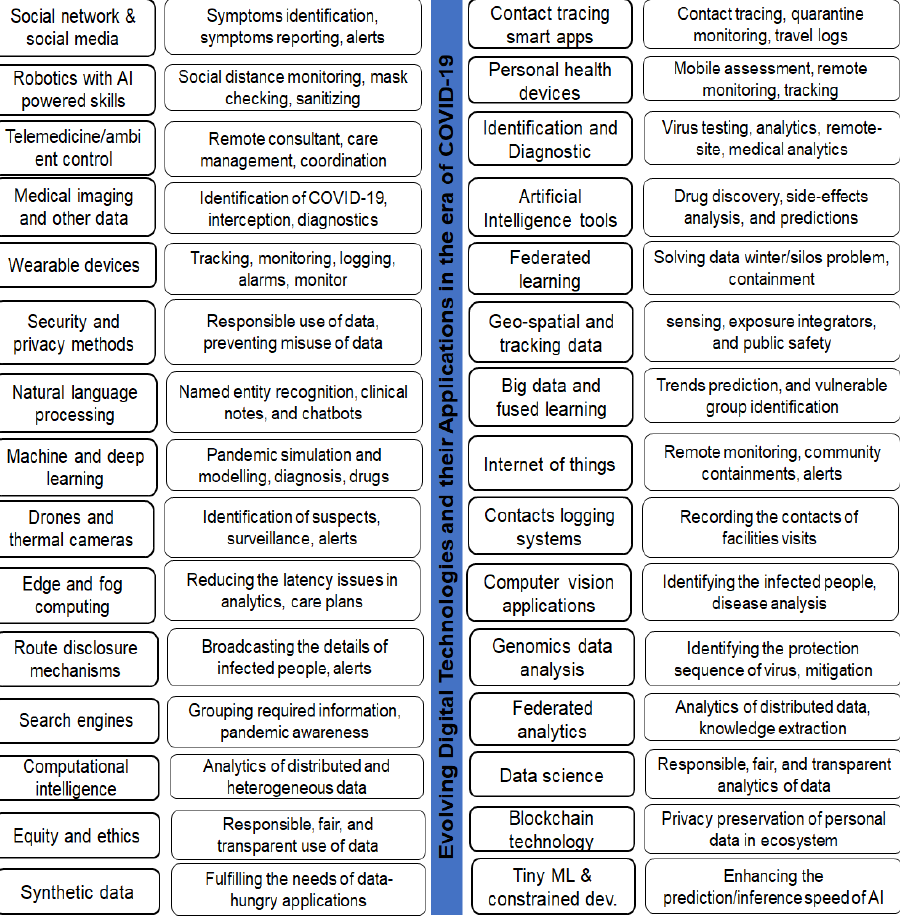
Figure 3. Emerging technologies and their applications in the era of